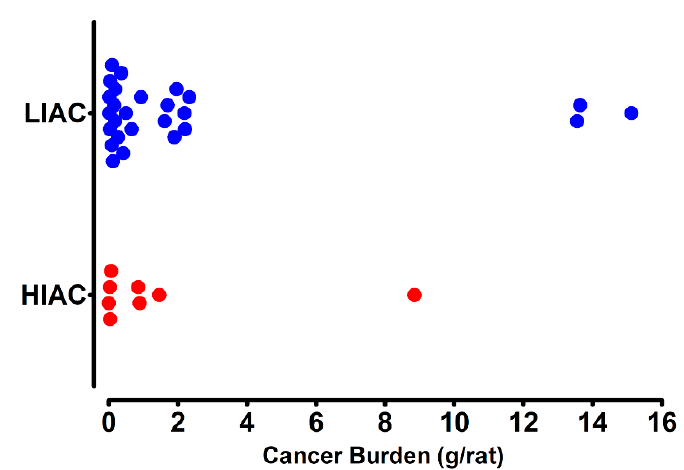
Figure 1. Effect of inherent aerobic capacity on tumor burden. Total tumor mass per rat was computed and is displayed for rats with high (HIAC, red dot) or low (LIAC, blue dot) inherent aerobic running capacity. Cancer burden was 0.21 ± 0.16 g/rat, p < 0.001, in HIAC, which was significantly lower than in LIAC (1.14 ± 0.45, p < 0.001).